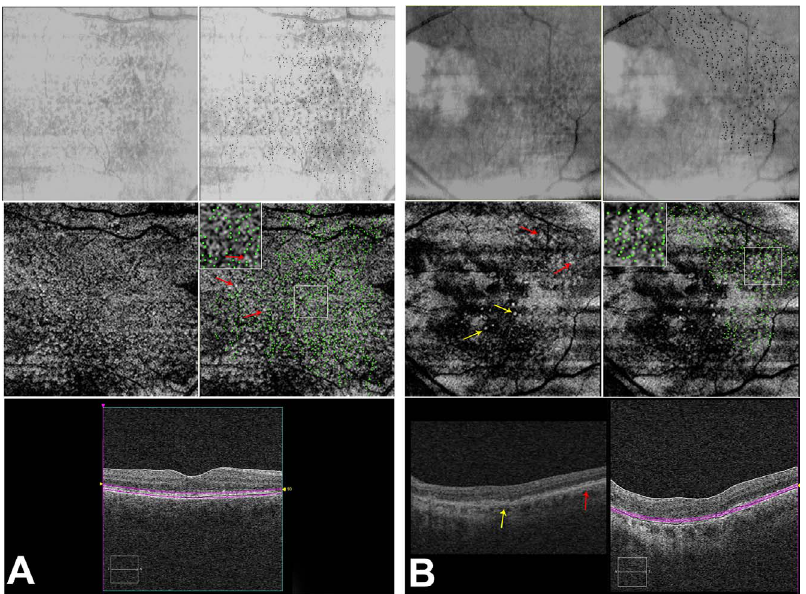
Figure 6. Correlation of RPD lesions on IR reflectance to the sub-retinal drusenoid deposits (SDD) on OCT and comparison of regular drusen with SDD on OCT. 6A: IR reflectance (top left), IR reflectance with individual RPD lesions marked in black (top right). En face OCT C-scan (middle left) taken at the level of photoreceptors, as shown on b-scan (bottom) showing the sub-retinal drusenoid deposits (SDD; white lesions, yellow arrows). Middle right panel shows an overlay of the RPD lesions from IR (green dots) onto the en-face scan demonstrating the relative lack of overlap between the SDD and the RPD, with the inset providing a magnified view. OCT B-scan (bottom right) highlighting in purple, the location of the en face section. 6B: shows a different eye, which has SDD as well as small hard drusen. Hard drusen are marked by yellow arrows on the C scan (middle left) and the B-scan (bottom left). On en face OCT, hard drusen appear as well defined distinct white lesions surrounded by a ring of hypo-reflectivity (yellow arrows on B-scan and en face images). In contrast, SDD (marked by red arrows on the B-scan and en face images) have relatively indistinct borders, occur in clusters and appear to blend into an isointense background. OCT B-scan (bottom right) highlighting. in purple, the location of the en face